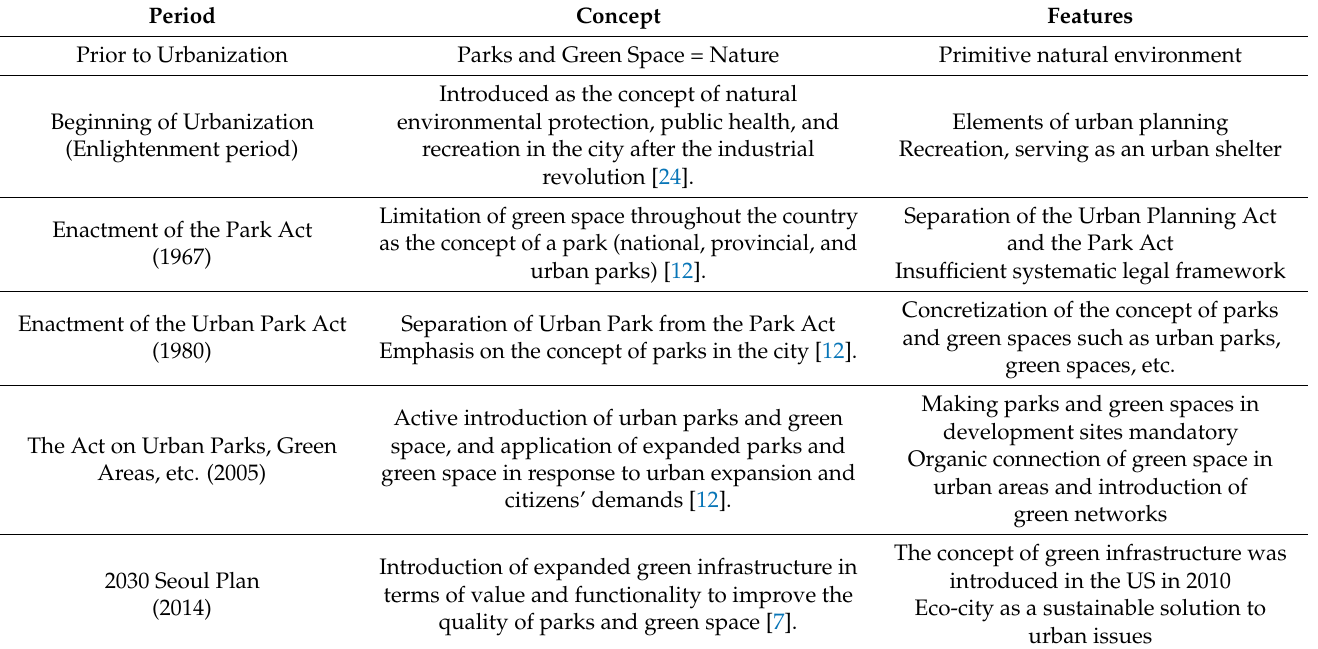
Table 2. History of the concept of parks and green space in Seoul by